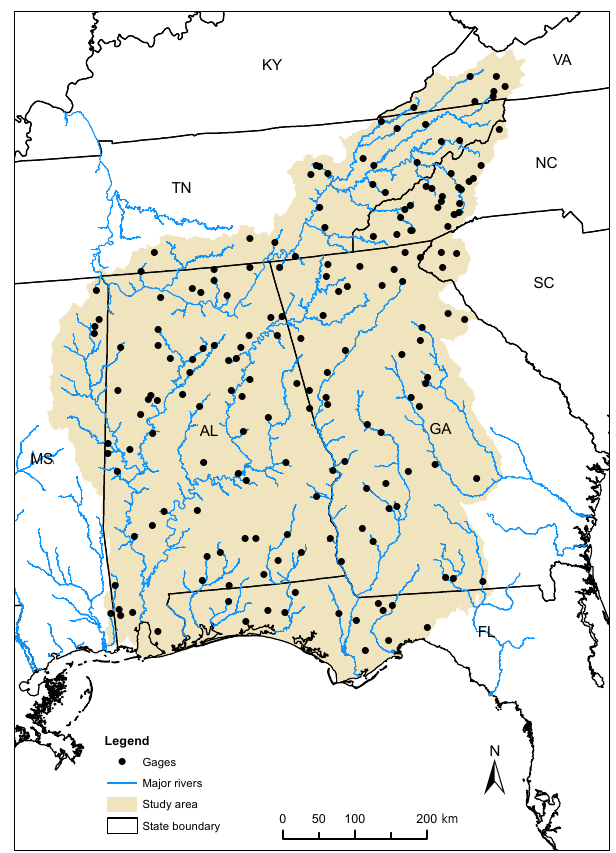
Figure 1. Map of the study area showing the locations of the 182 streamgages used for analysis and